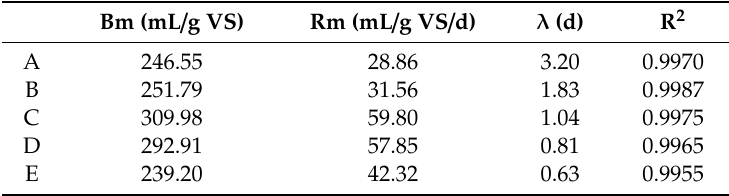
Table 5. Kinetic parameters of the modified Gompertz equation for methane production.